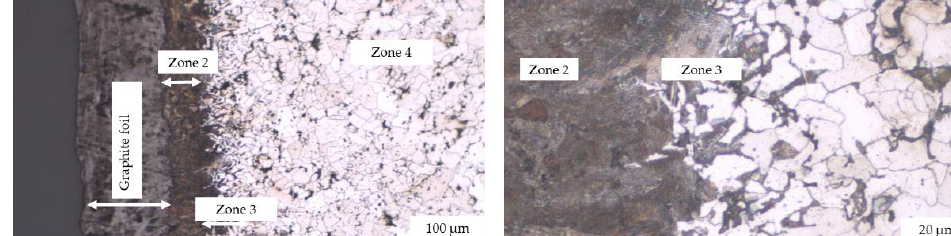
Figure 7. OM views of the side of the iron sample sintered using graphite foils without coating.